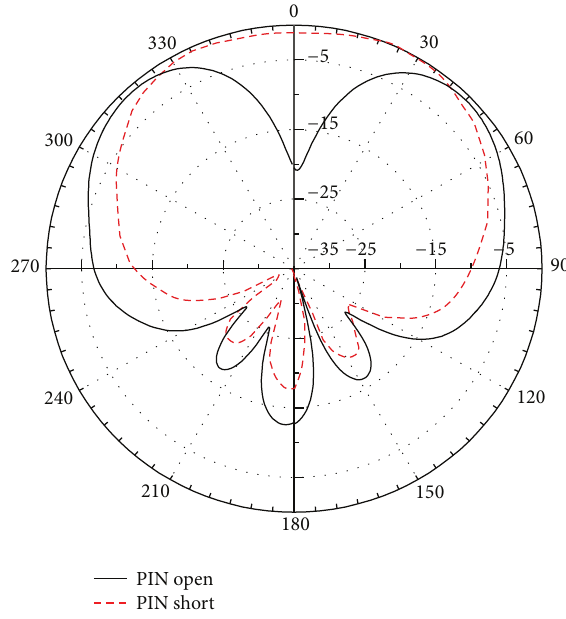
Figure 7: Measured radiation patterns of switchable surface wave antenna in y - z plane for pin diodes open and short circuit.